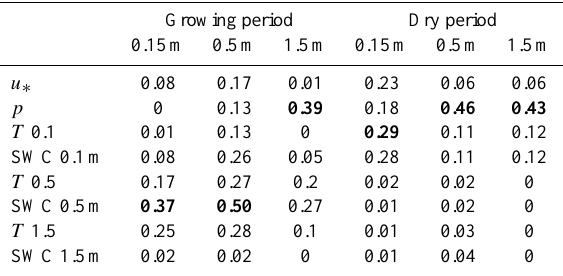
Table 2. Correlation coefficients ( R 2 ) during both the growing pe- riod and the dry period between soil CO 2 molar fractions ( χ c ) at three depths (0.15, 0.5 and 1.5m), versus environmental parame- ters: friction velocity ( u ∗ ), pressure ( p) and soil temperatures ( T ) and soil water contents (SWC) at the same three depths. Highlighted values denote the highest magnitudes for each depth. Growing period Dry period 0.15m